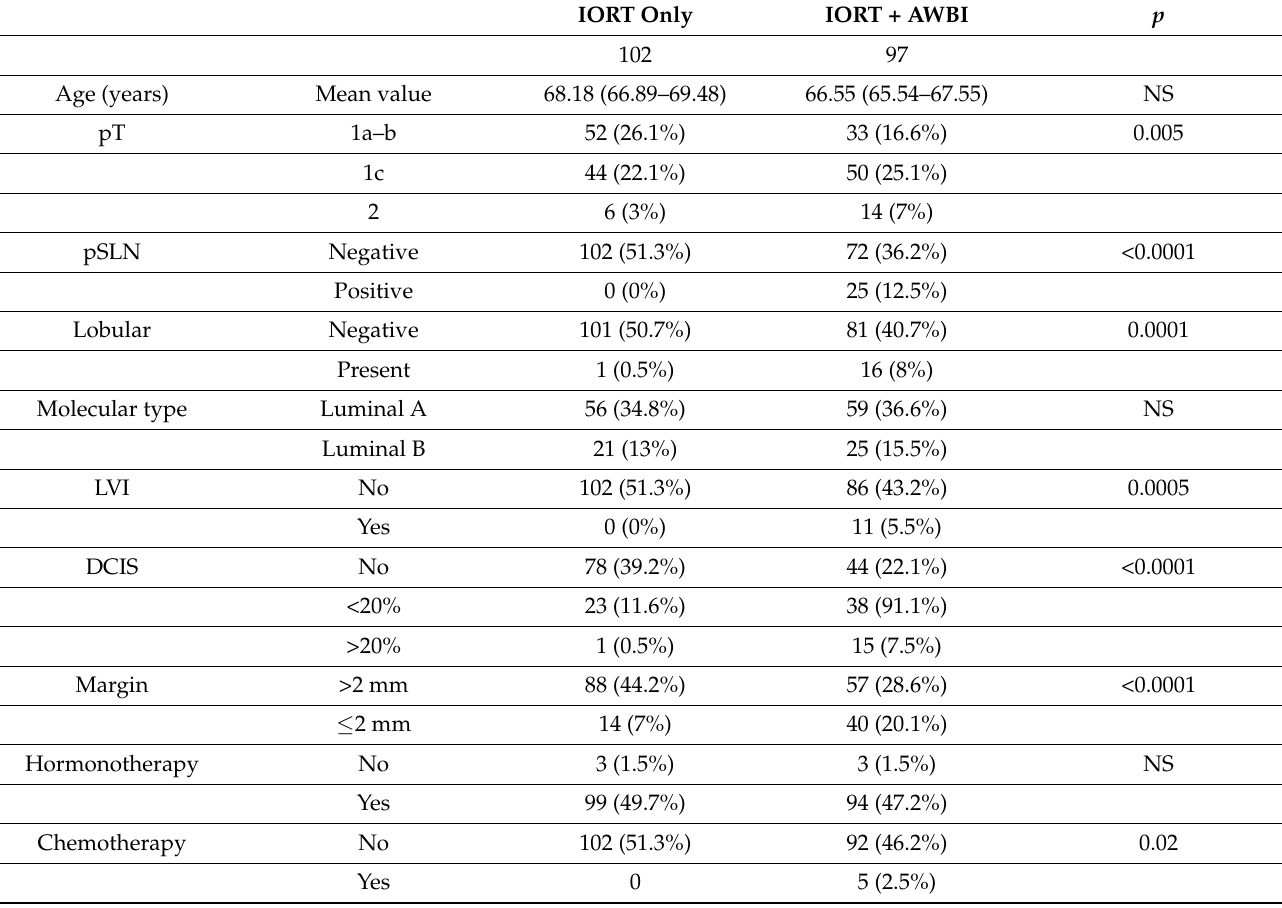
Table 4. Characteristics of patients treated with the IORT